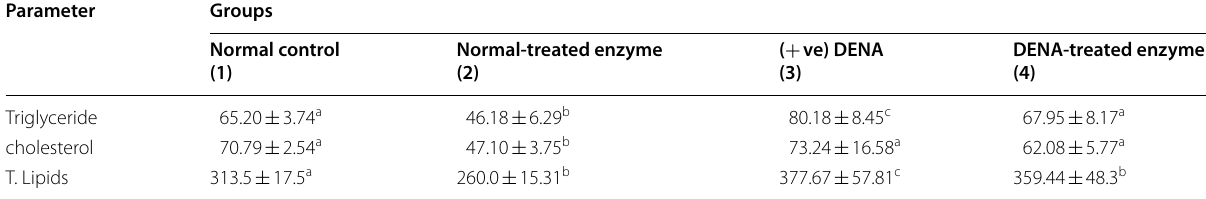
Data are expressed as means SD of six mice in each group ± Analysis of data is carried out by one‑way (ANOVA) (analysis of variance) accompanied by post hoc (LSD, least significant difference) (CoStat, computer program) Different letters indicate that these groups are significantly correlated at P > 0.05 Different letters are significantly different from each other while similar letters are not significantly different at P < 0.05 Table 4 Effect of T. viride l ‑asparaginase on lipid profile in serum of control and DENA‑intoxicated